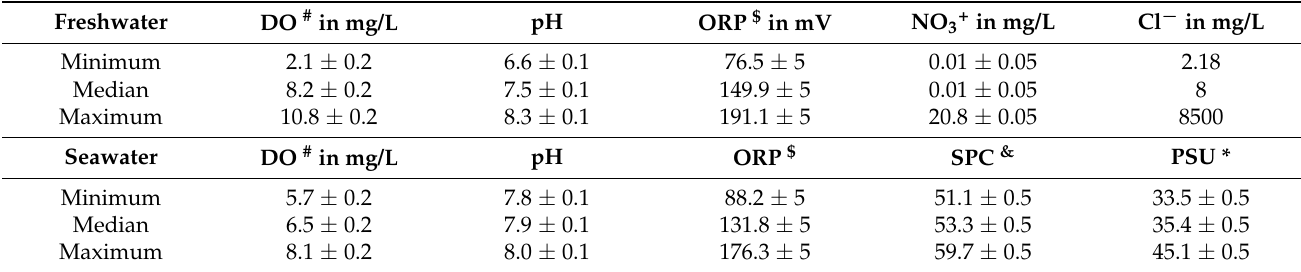
Table 1. Physicochemical parameters overview showing minimum, maximum and median values of FW and SW samples with instrument standard errors (±SE) for each measurement.